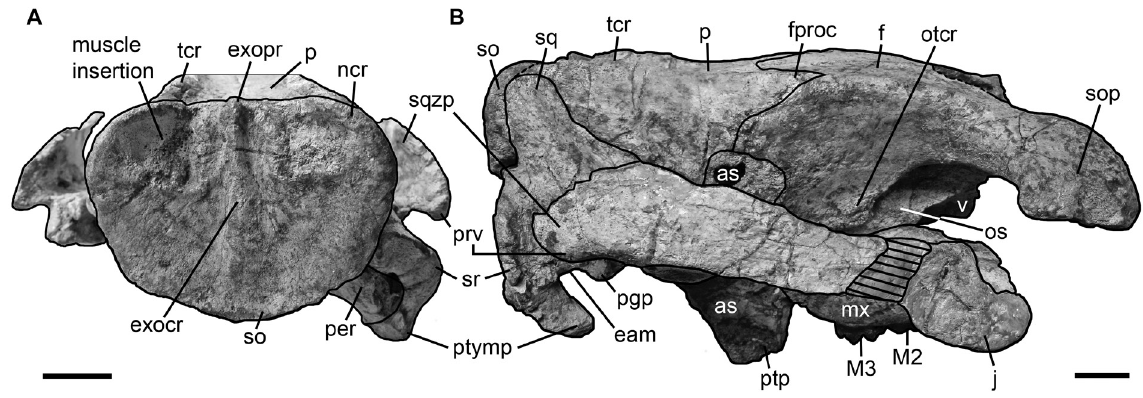
Fig. 4. Cranium of Lentiarenium cristolii ( Fitzinger, 1842) (OLL 1926/394). A . In caudal view. B . In right lateral view. Shaded area indicates either missing or reconstructed part. Scale bars = 2